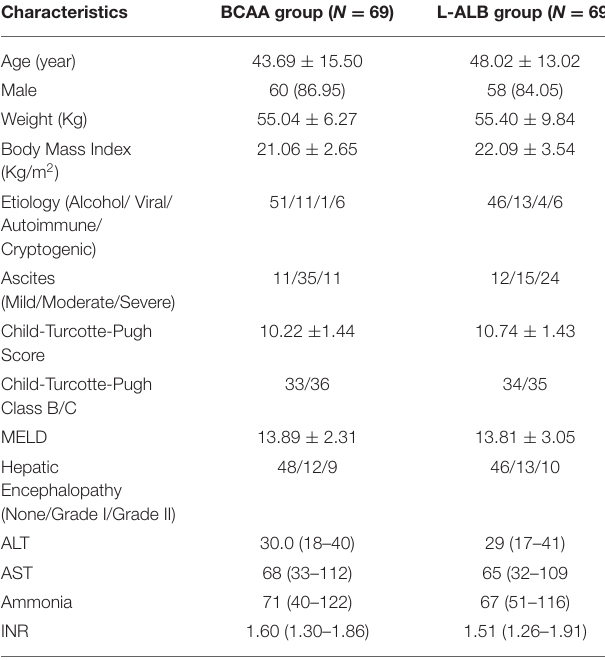
TABLE 2 | Baseline characteristics of 106 patients who completed the study till 24 weeks.